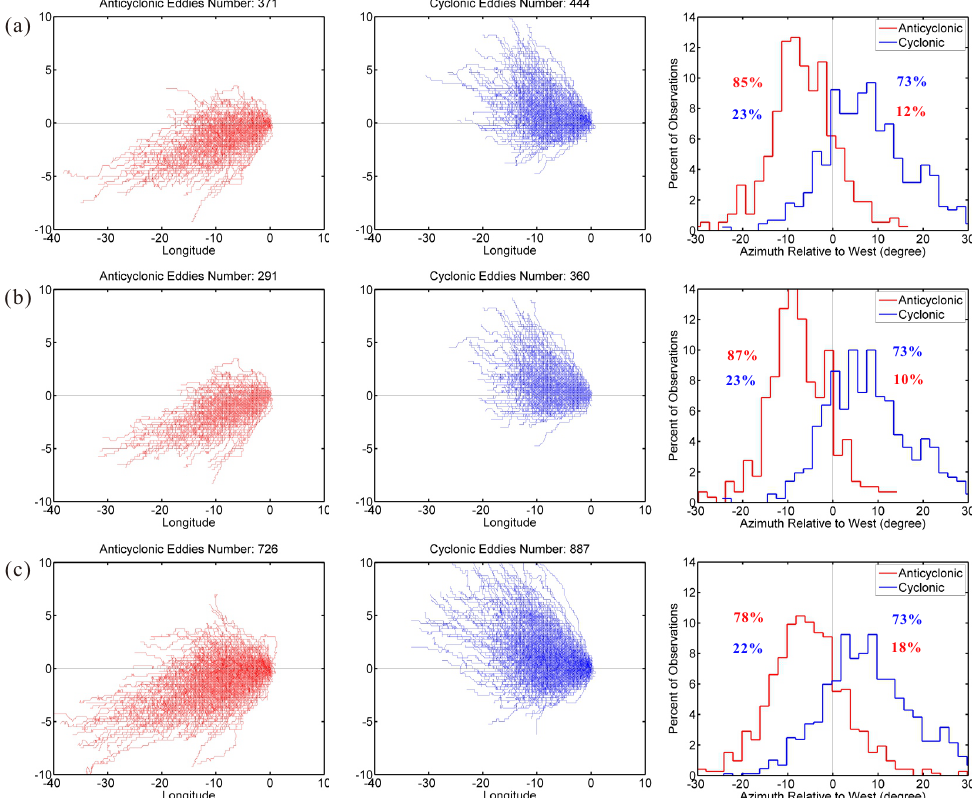
Figure 14. Meridional deflections of anticyclonic (left column panels) and cyclonic (middlecolumn panels) eddies with lifetimes longer than 16 weeks that propagated westward for a minimum of 10 ◦ longitude based on the three methods: ( a ) CH11; ( b ) Similarity and ( c ) Hybrid. The left and middle panels show the changes in longitude (negative westward) and latitude (positive for poleward and negative for equatorward due west) relative to the (0, 0) location for anticyclonic and cyclonic eddies. The right panels show histograms of the average azimuth of each eddy trajectory, defined in the left and middle columns. The labels in the right panels indicate the percentages of negative (left) and positive (right) eddy